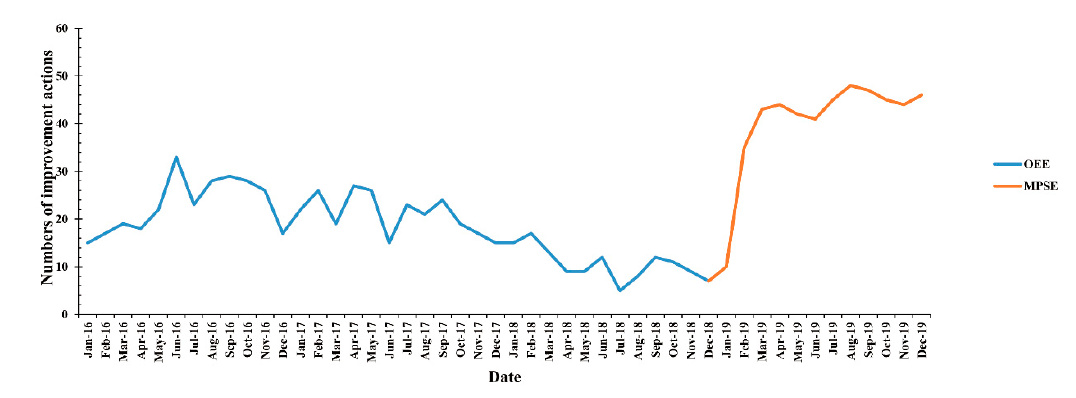
Figure 10. Number of improved actions with OEE and MPSE.